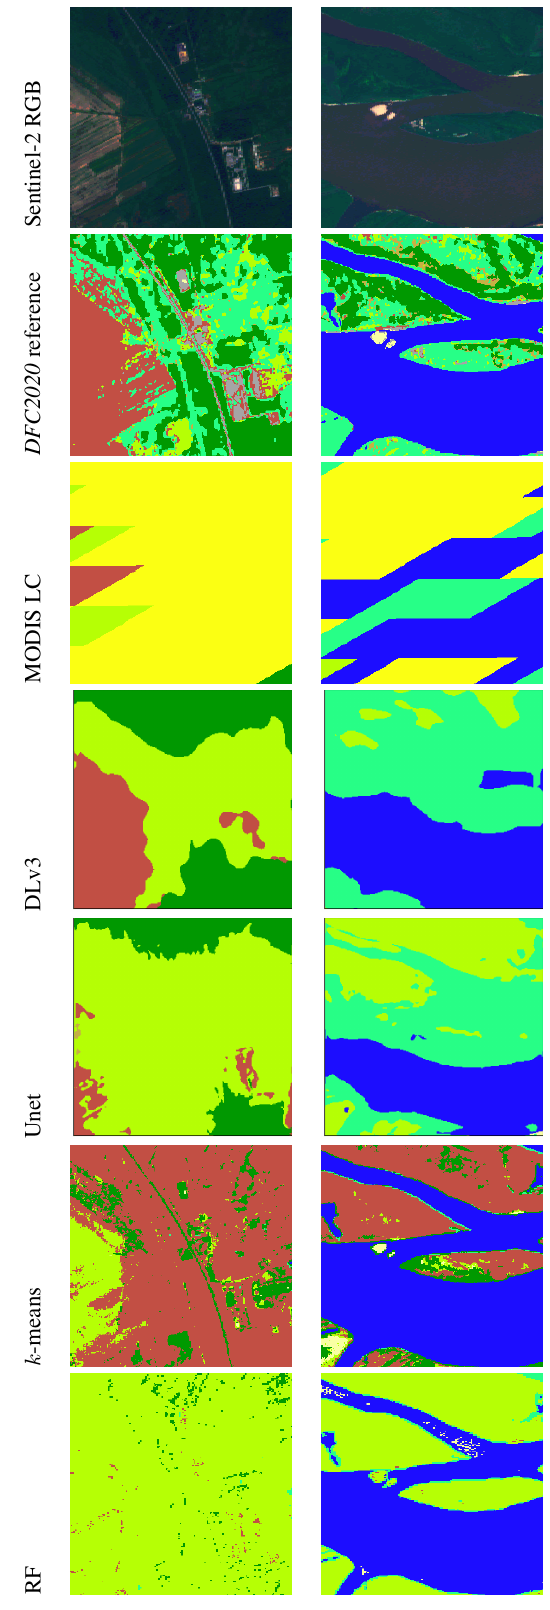
Figure 6. Land cover mapping results achieved with the baseline models for two example patches. Note that for Unet and DLv3 the models based on Sentinel-1 and Sentinel-2 data fusion and achieved after the first training epoch were used to predict the maps shown in this figure, as they provided a visual upper